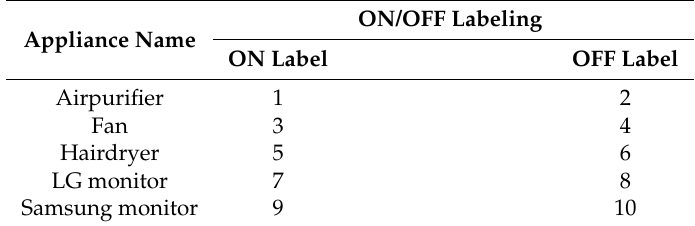
Table 5. Labeling ON/OFF for each appliance.